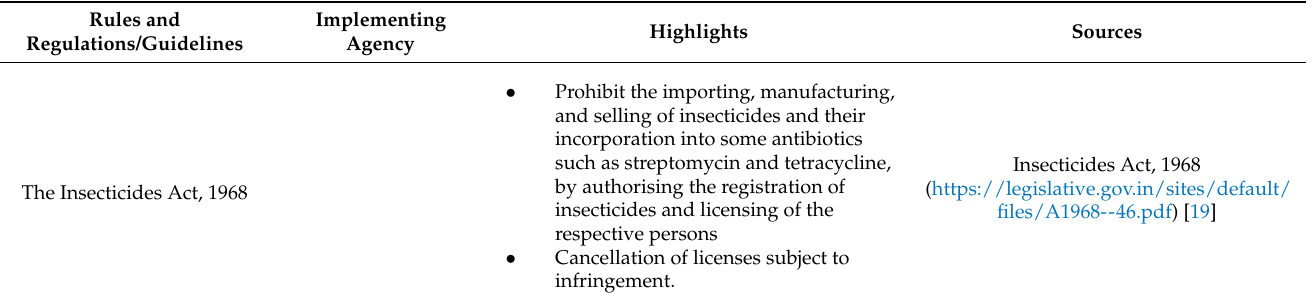
Table 1. Existing policies/guidelines/legislations for restricting antibiotic usage on plant agriculture in